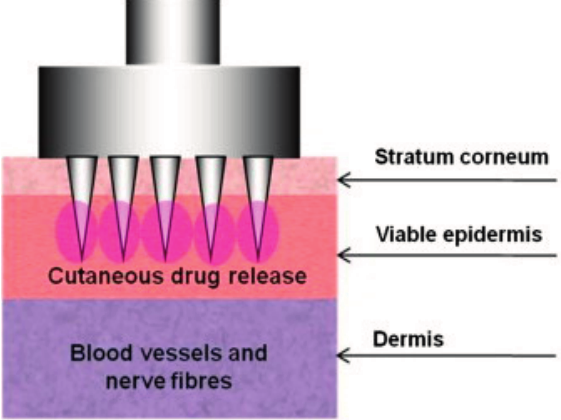
Figure 13. Schematic representation of the mechanism of action of a microneedle array device. The device perforates the stratum corneum (SC) providing direct access of drugs to the underlying viable epidermis, without reaching blood vessels and nerve fibres located in the dermis (Reprinted from [12] with permission. Copyright 2013